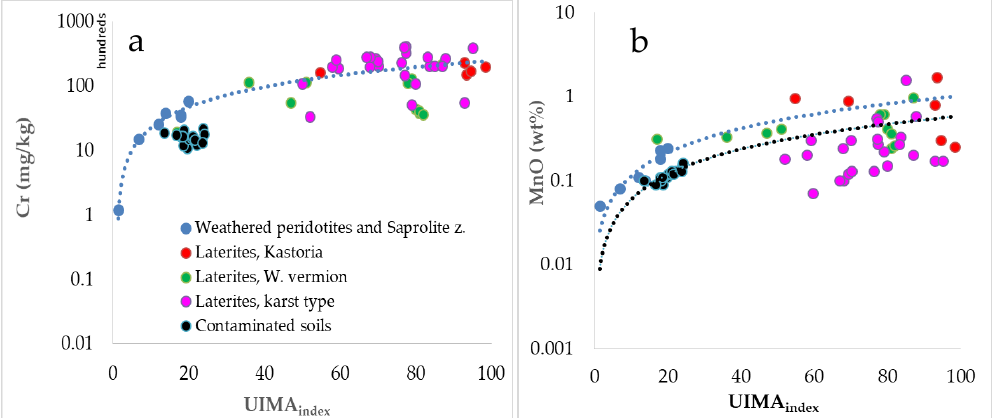
Figure 1. Plots of the UMIA (calculated ultramafic index of alteration) versus Cr contents in weathered peridotites and saprolite zone, laterites from Kastoria and W. Vermion lying on peridotites, laterites of karst type from Lokris, and contaminated soils from Evia. Data from Table 1 and [50].